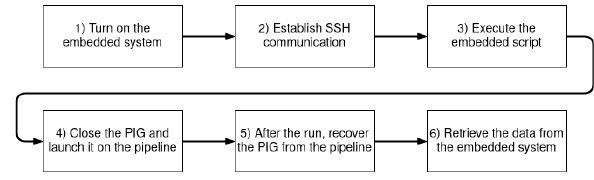
Figure 37. Steps of the data collection